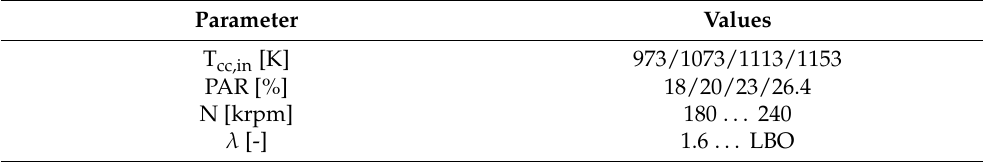
Table 5. Test conditions for atmospheric test